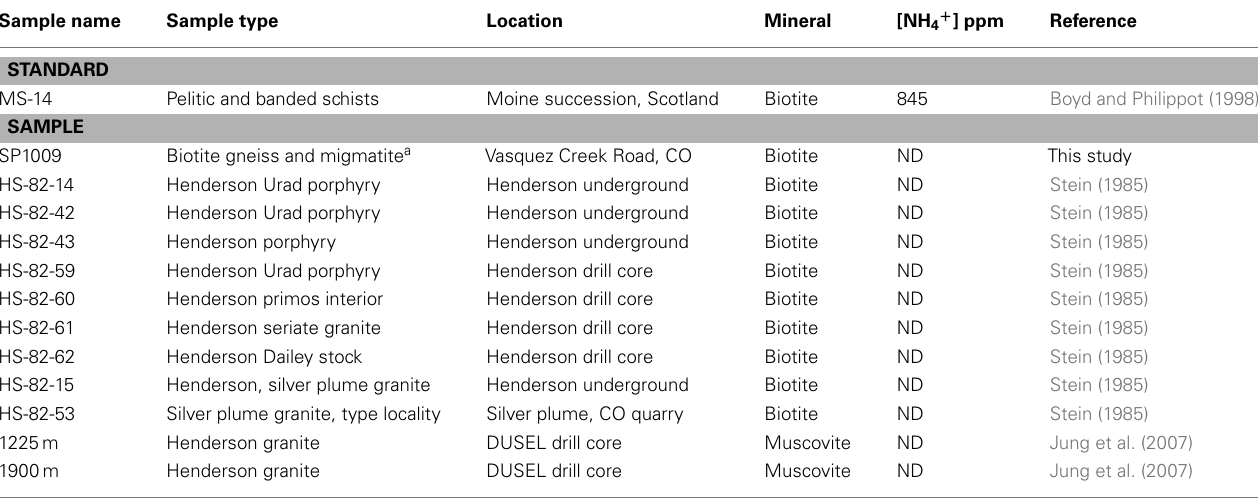
Table 1 | Potassic minerals for FTIR